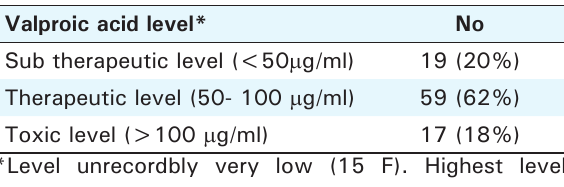
Table 5. Serum level of Valproic acid (n=95) Valproic acid level* No Sub therapeutic level (<50 µ g/ml)